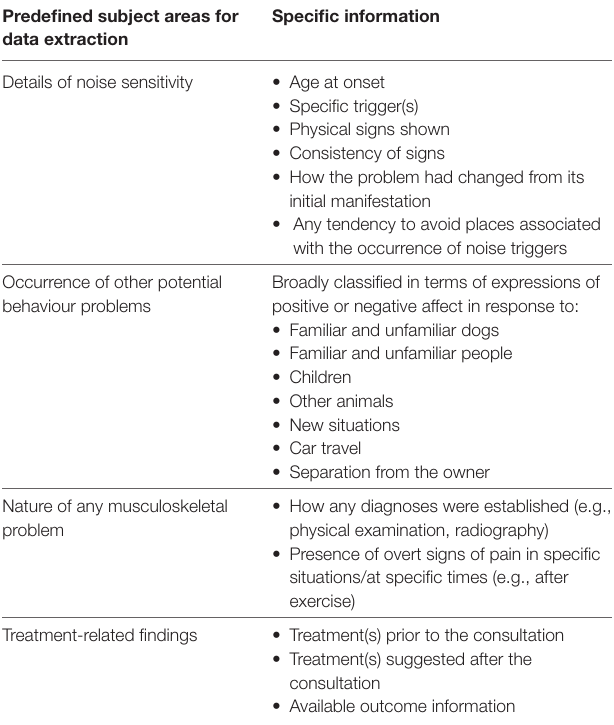
tABLe 1 | Predefined subject areas for data extraction in “control cases” and “clinical